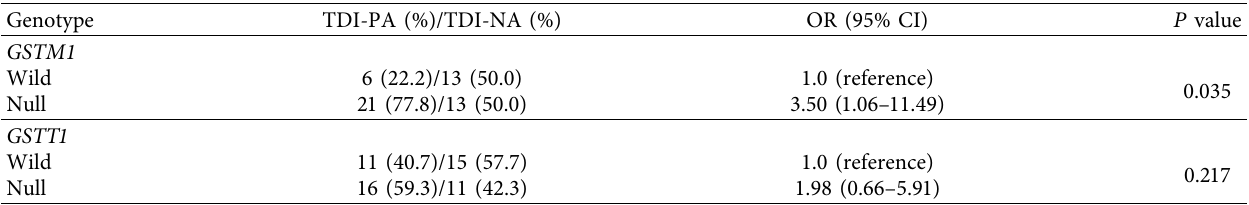
Table 2: Comparison of GSTM1 and GSTT1 genotype frequencies according to the response of the TDI challenge. Genotype